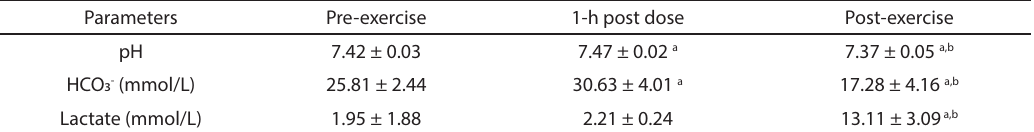
Table 2. Results of blood biochemical responses to NaHCO3 at baseline (pre-exercise), 1 h after ingestion, and at after exercise in 13 well-trained sprinters. Data were analysed using one-way